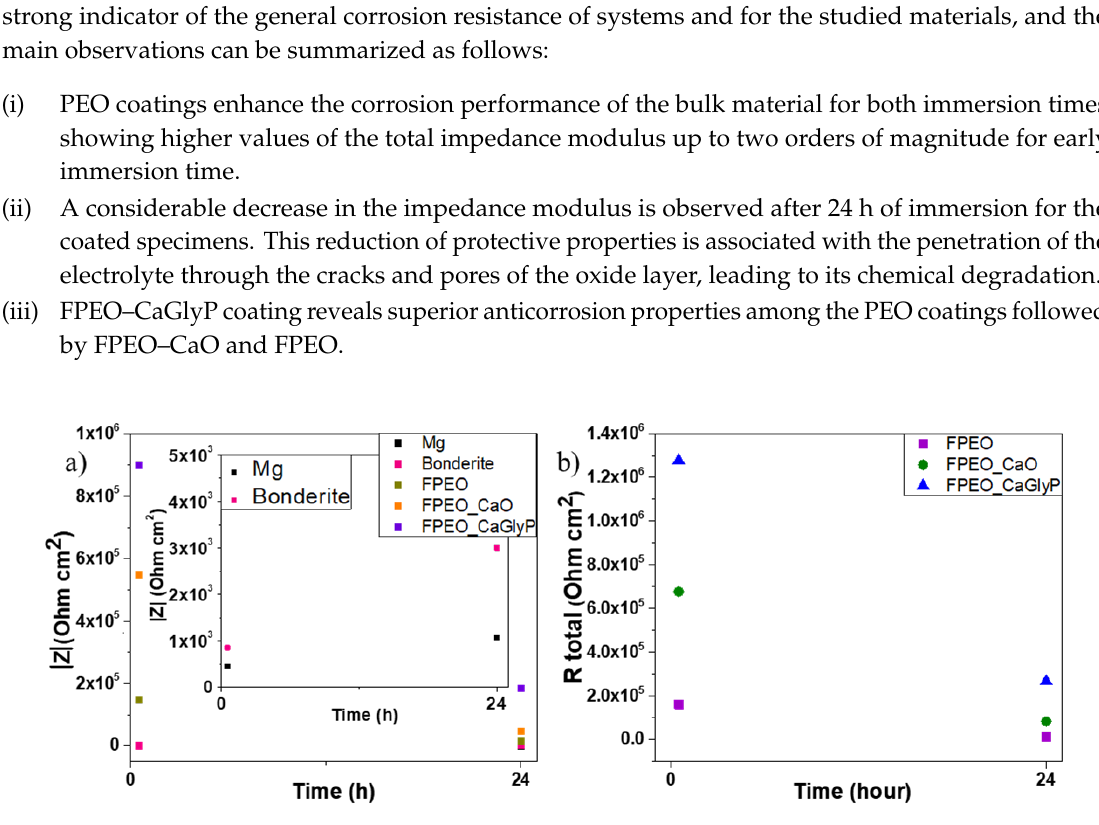
Figure 6. ATR FTIR microscopy spectra and the ATR FTIR spectra (inset) of the flash-PEO coatings.